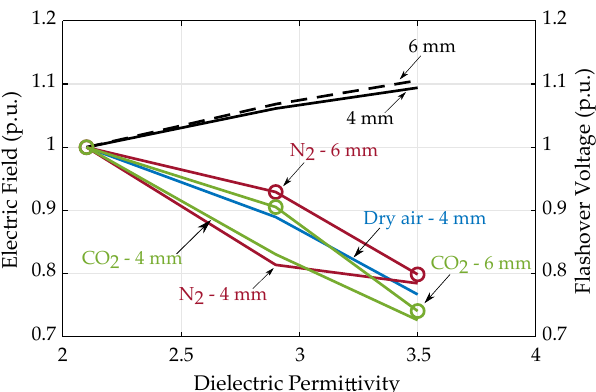
Figure 8. Computed electric field (black curves) and measured flashover voltages over dielectric permittivity variation. All the curves are normalised over the corresponding value of ε r = 2.1 for PTFE.